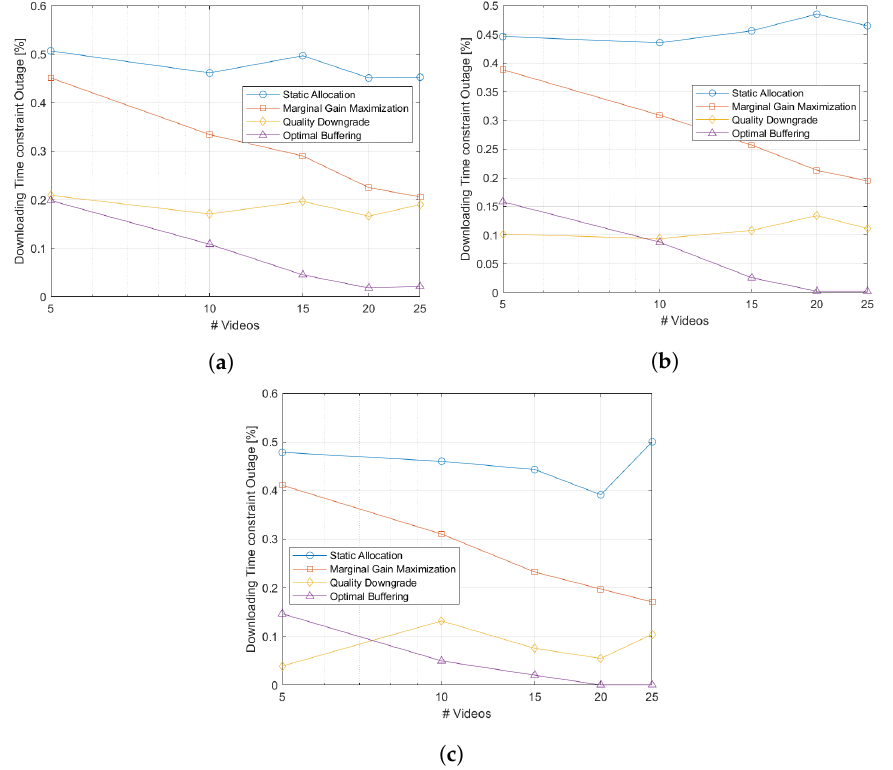
Figure 9. Outage probability with respect to downloading time constraint with variable number of videos. ( a ) Short videos. ( b ) Medium videos. ( c ) Long videos.